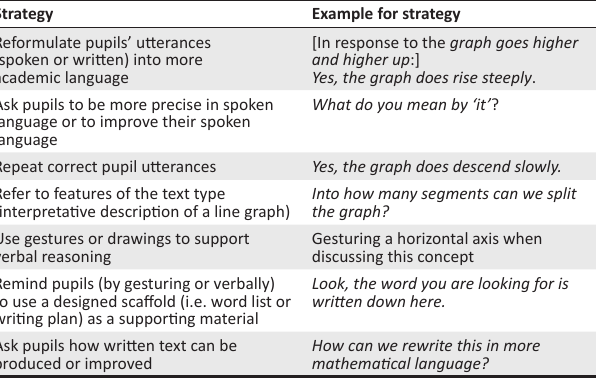
TABLE 1: Strategies for scaffolding language and examples for each